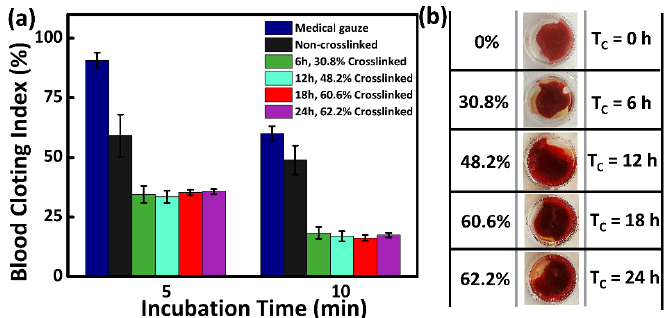
Figure 6. ( a ) Results of whole blood clotting formation on the medical gauze, non-crosslinked and GA crosslinked electrospun membranes. The clotting formation capacity is expressed as the blood clotting index (BCI), which reflects the free RBCs not trapped in clots. ( b ) Macroscopic view of whole blood clot formation on various crosslinked electrospun membranes.